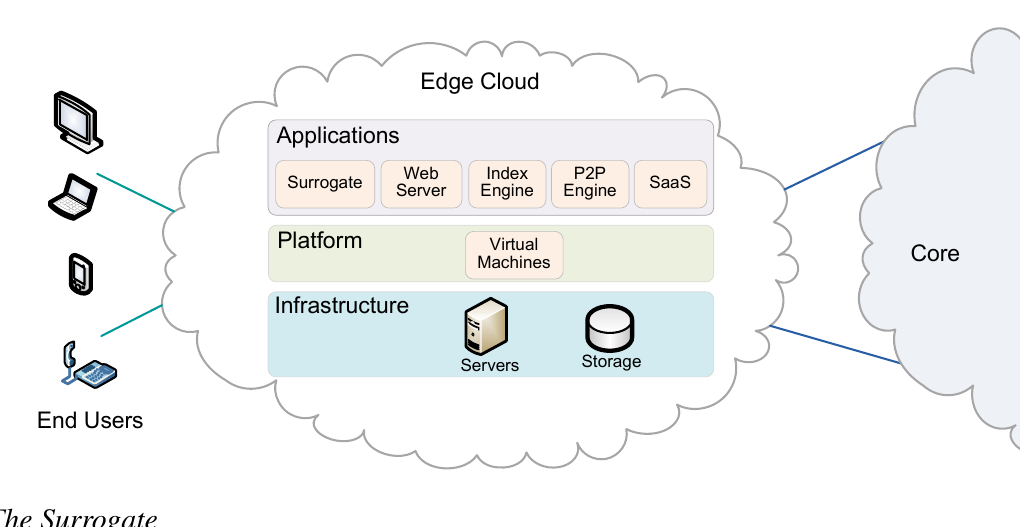
Figure 3. Inside the Edge